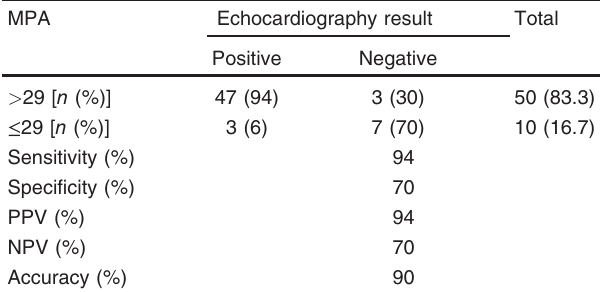
Table 11 Evaluation of different parameters; sensitivity, specificity, positive predictive value, and negative predictive value for main pulmonary artery more than 29